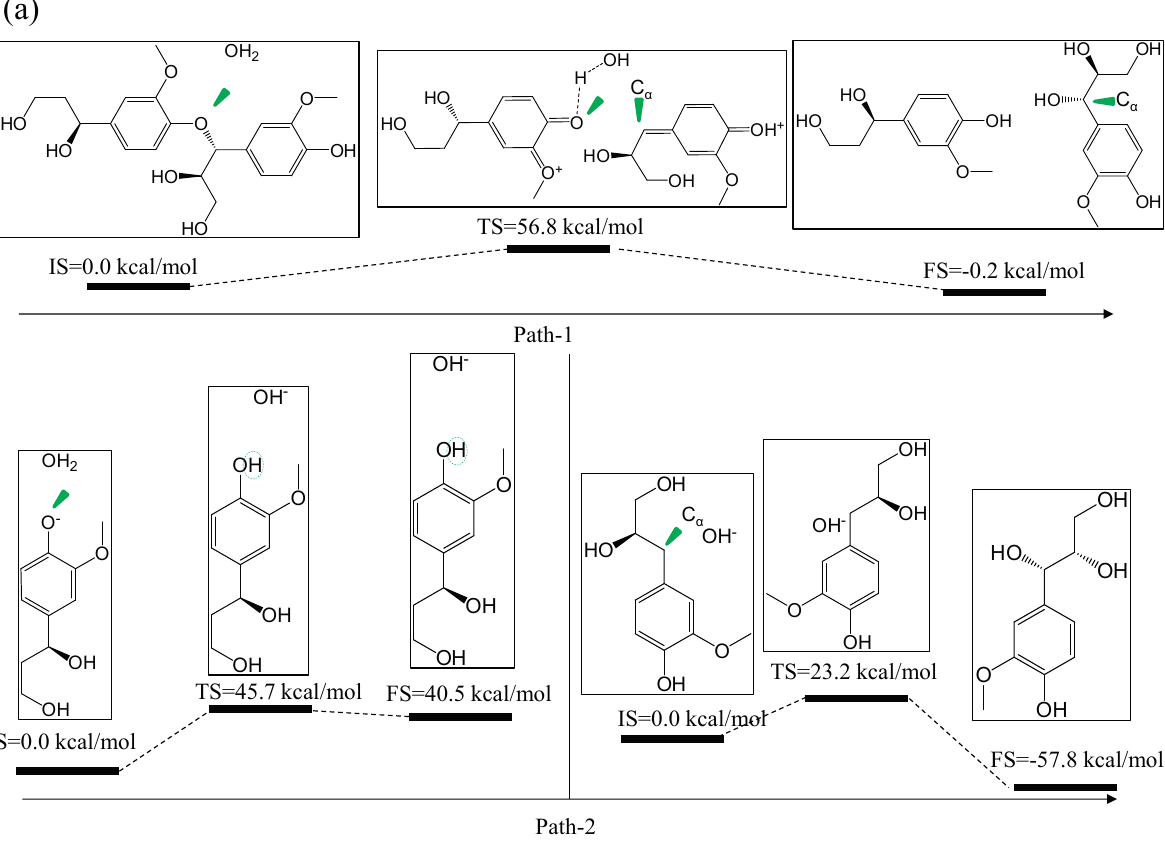
Figure 4. The calculated potential energy profiles for the direct one-step hydrolysis of lignin ( a ) α -O- 4 linkage and at ( b ) β -O- 4 linkage, and the referenced two-step hydrolysis of the decomposed